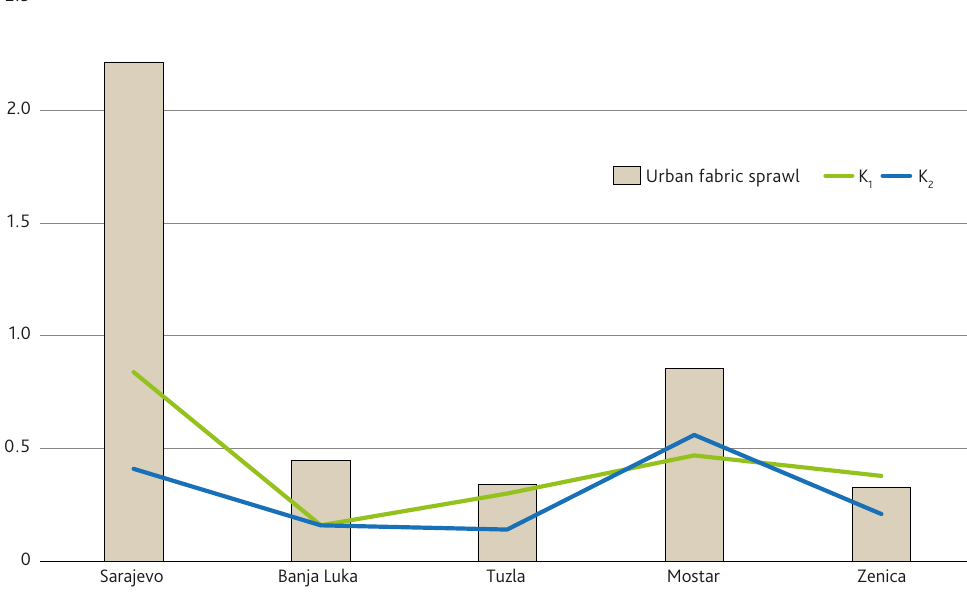
Figure 9. Absolute and relative values of urban